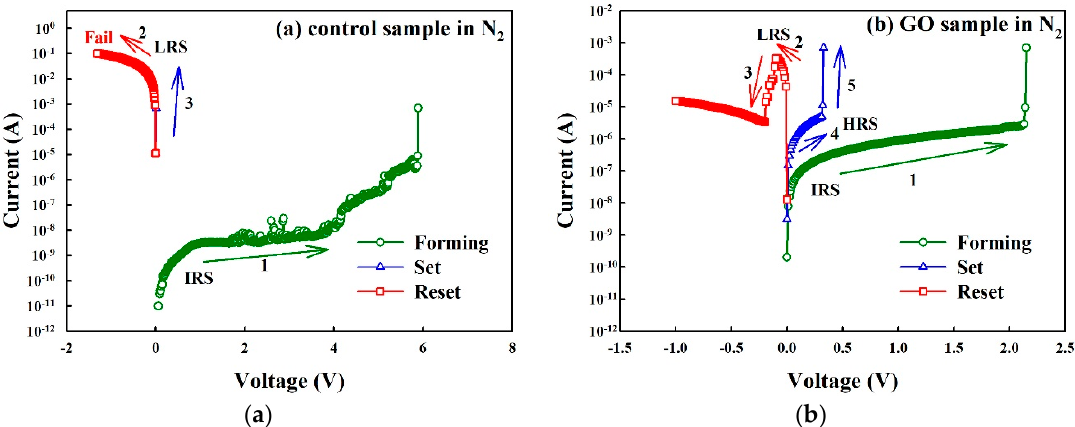
Figure 3. ( a ) Resistive switching (RS) properties of the control and ( b ) GO samples in the N 2 ambient. LRS: low-resistance state; IRS: initial-resistance state; HRS: high-resistance state.